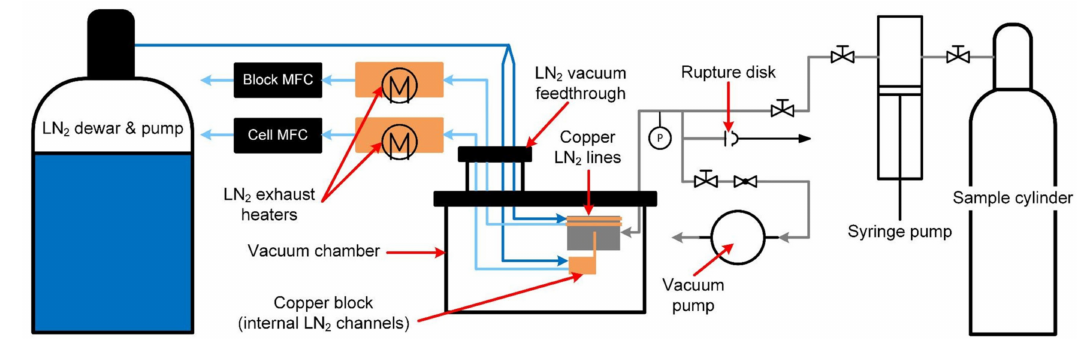
Figure 2. Small visualization device built by Sampson et al.